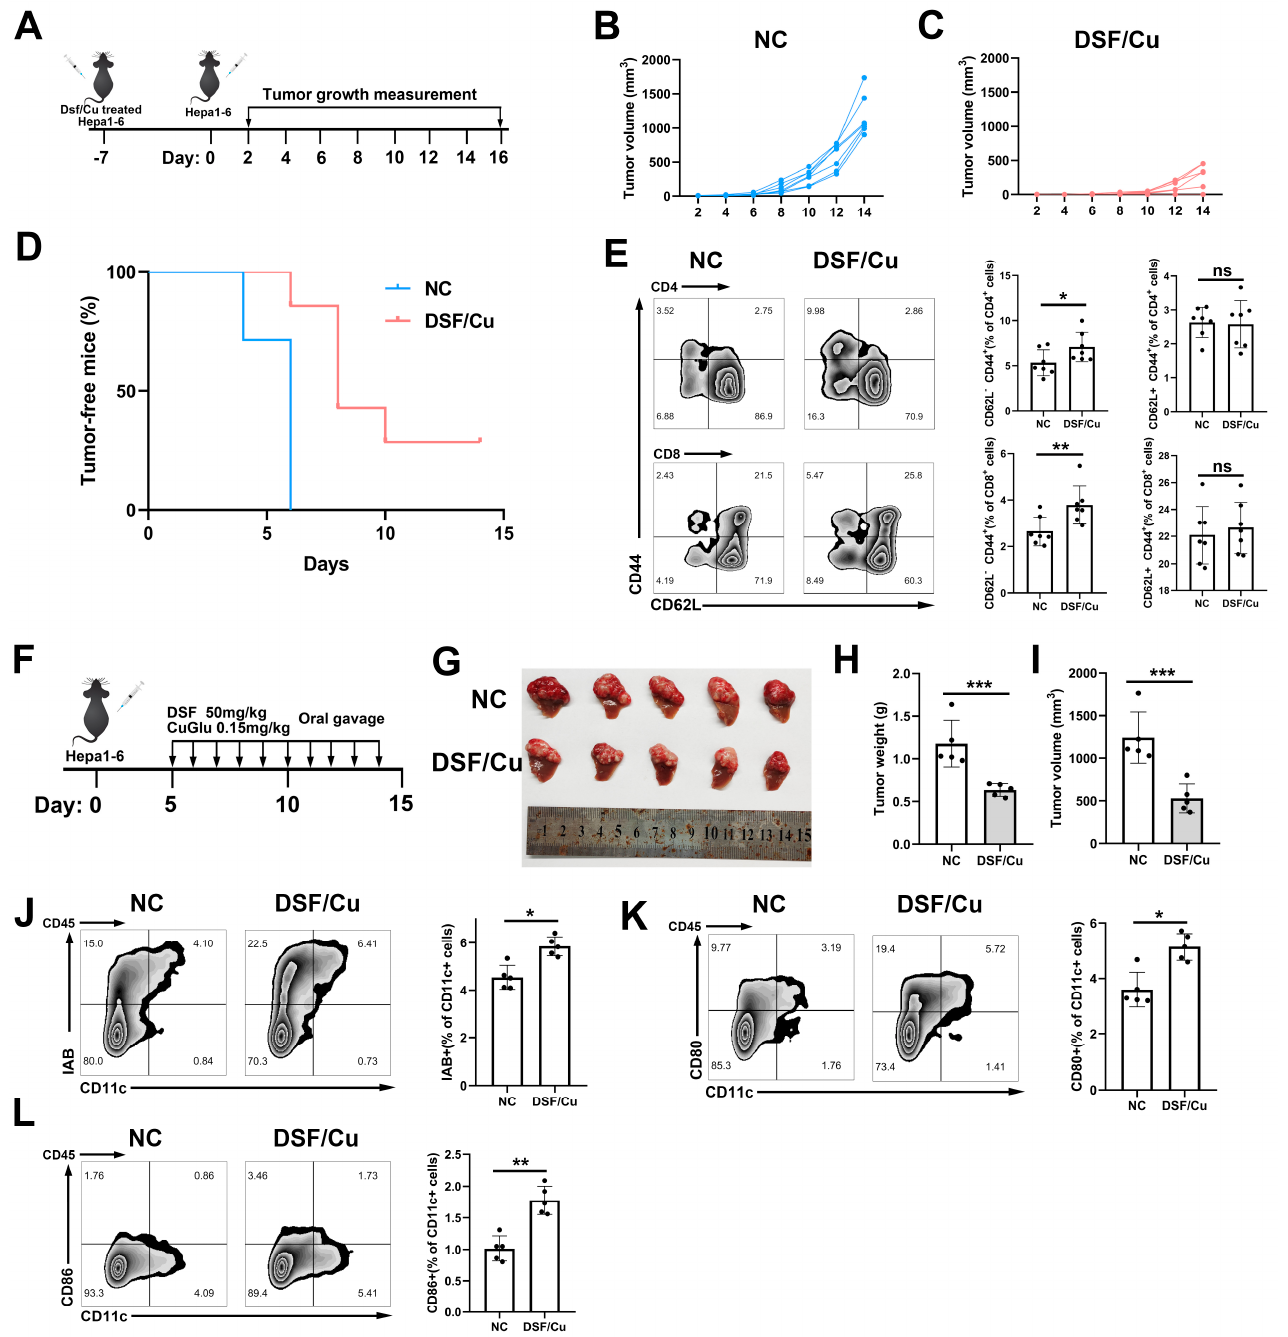
Figure 5. DSF/Cu induced intratumor immune cell infiltration in vivo. ( A ) A schematic view of the vaccination experiments. Individual tumor growth of normal control ( B ) or DSF/Cu-treated Hepa1–6 cells ( C ) measured every 2 days (n = 7 for each group). ( D ) Tumor-free survival analysis by Kaplan–Meier curves. ( E ) Analysis of the percentage of effector memory- (CD44 − , CD62L + ) and central memory- (CD44 + , CD62L + ) T cells. ( F ) A schematic view of the orthotopic tumor model for DSF/Cu treatment. ( G ) Tumor appearance, ( H ) weight and ( I ) volume were compared with the other group (n = 5). Analysis of the percentage of ( J ) I-Ab + , ( K ) CD80 + , ( L ) CD86 + DC cells in CD45 + cells. ns: p > 0.05; *: p < 0.05; **: p < 0.01; ***: p < 0.001.